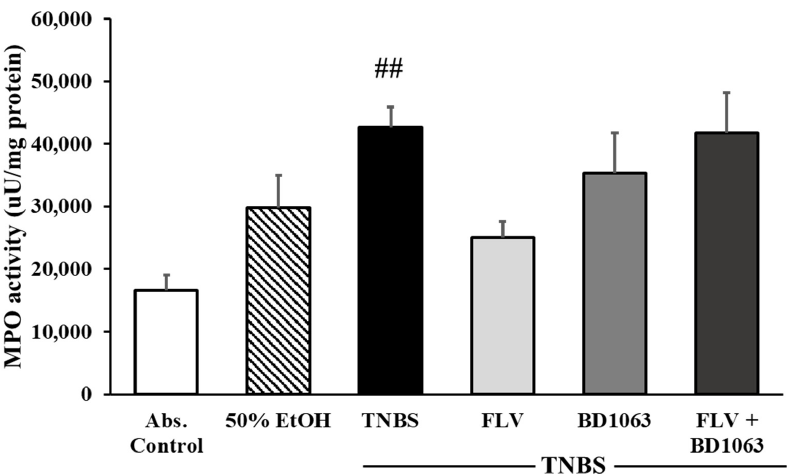
Figure 4. E ff ects of sigma-1 receptor ( σ 1R) on the activity of myeloperoxidase enzyme (MPO). Abs. control (no treatment), 50% EtOH (50% ethanol enema), TNBS (2,4,6-trinitrobenzenesulfonic acid enema), FLV (TNBS enema + 1 mg / kg Fluvoxamine (FLV)), BD1063 (TNBS enema + 0.1 mg / kg BD1063), FLV + BD1063 (TNBS enema + 1 mg / kg FLV + 0.1 mg / kg BD1063). Data are represented as mean ±